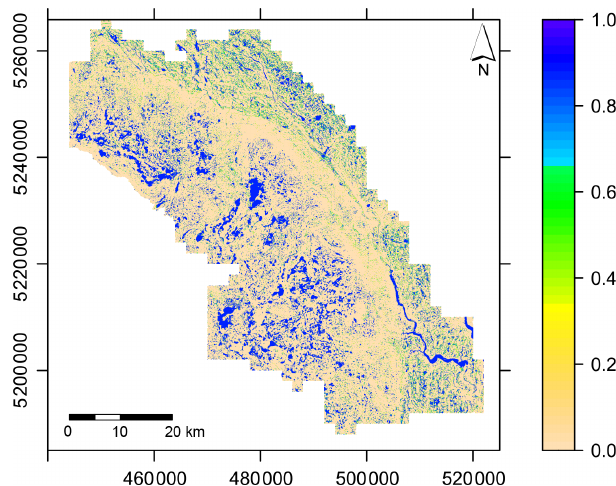
Figure 5. Map of prior water probabilities p(W) predicted from Eq. (7) with b 0 = 1 . 9479 and b 1 = − 3 . 5598. Scales show coordi- nates in the Universal Transverse Mercator system (UTM zone